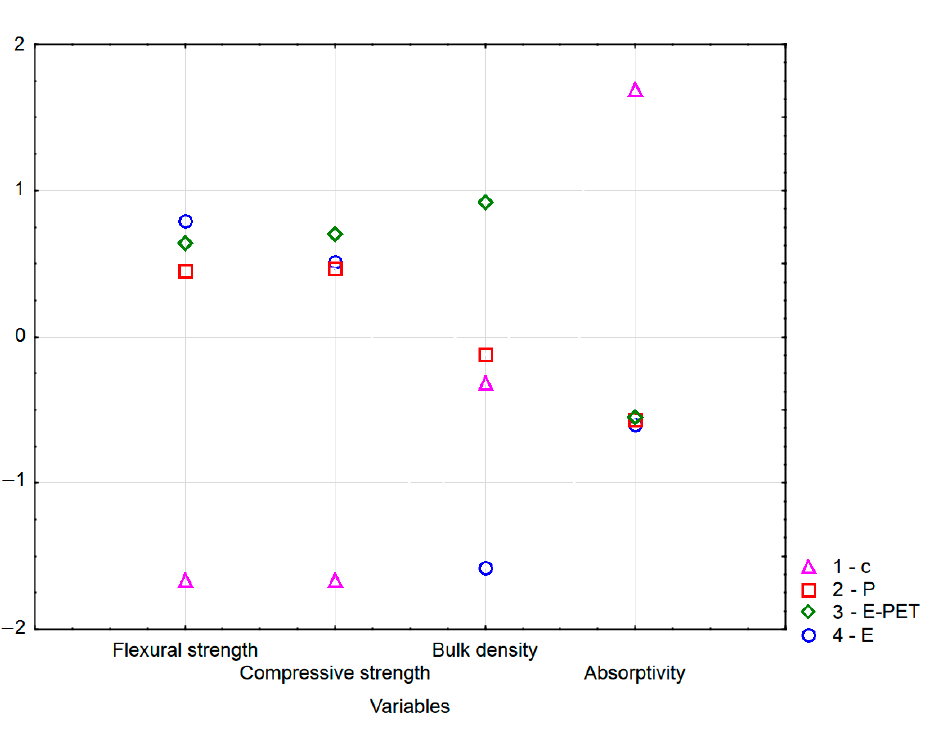
Figure 14. Graph of the normalized mean values of four properties designated for each